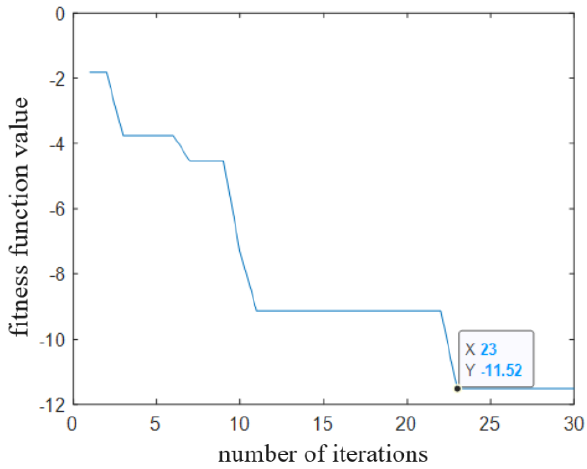
Figure 12. Fitness function curve of the outer ring experimental signal.